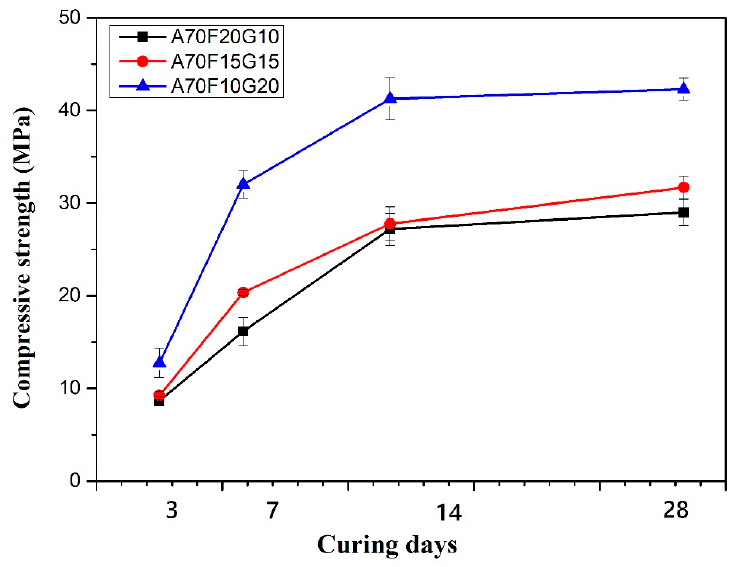
Figure 10. Effects of FA/GGBF ratios on the compressive strength of AFG geopolymer mortar.